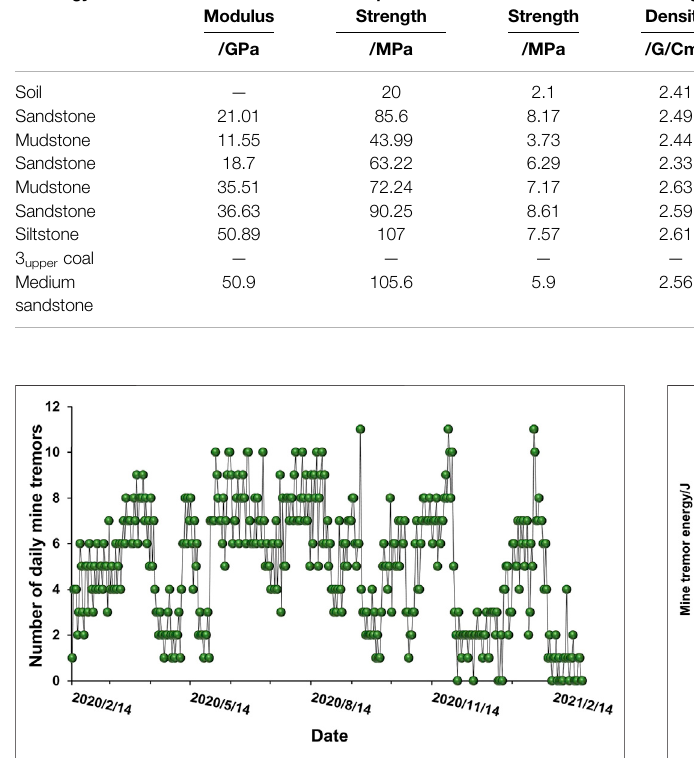
FIGURE 2 | Distribution of the mining-induced seismicities on the 63 upper 06 panel before the treatment.